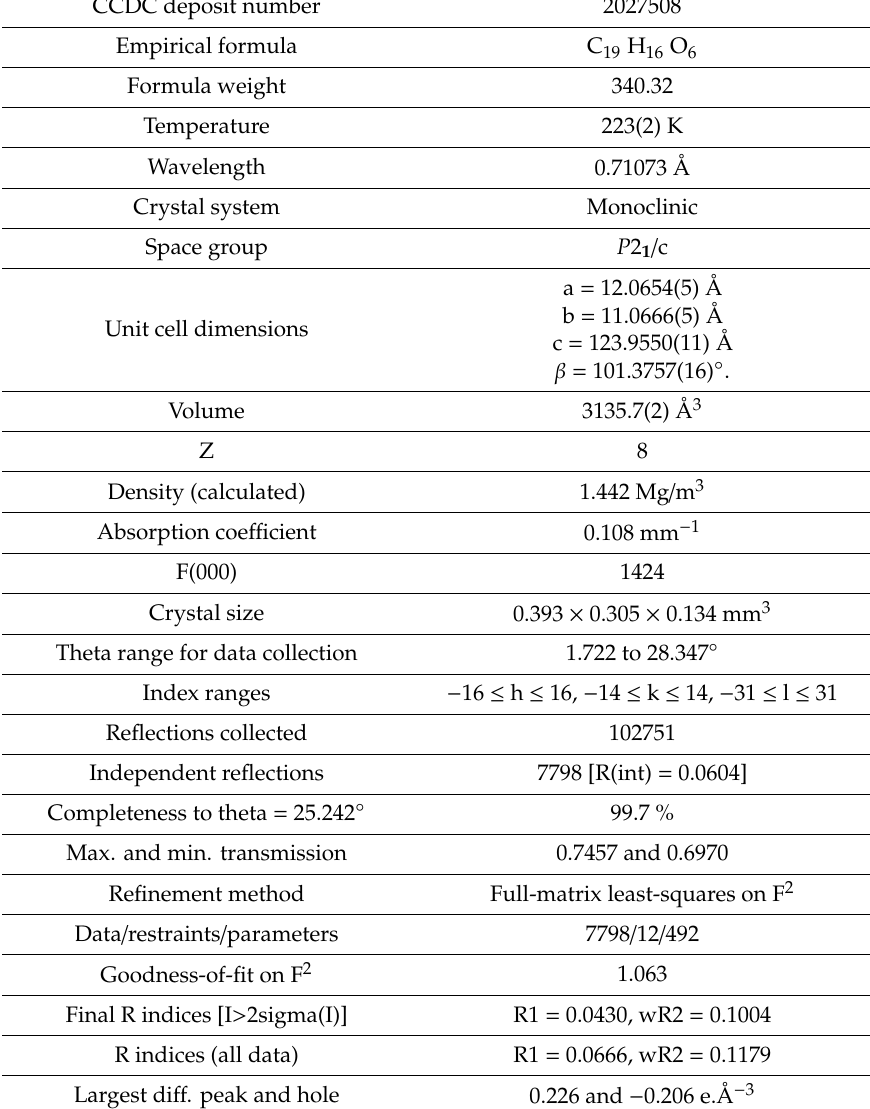
Table 1. Crystal data and structure refinement for compound 5